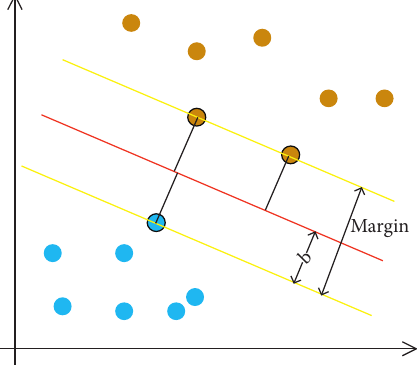
Figure 1: An illustration of the SVM for two